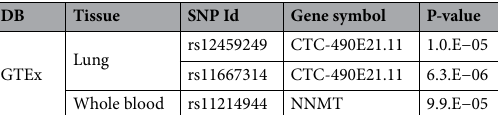
Table 4. eQTL among GWAS candidate SNPs in all subjects. eQTL expression quantitative trait loci.